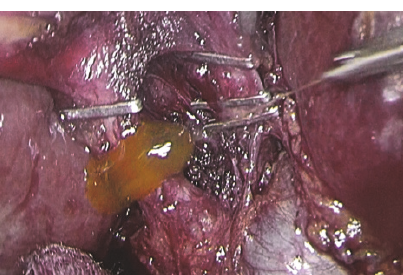
Figure 3: Flushing and bile outflow evaluation.